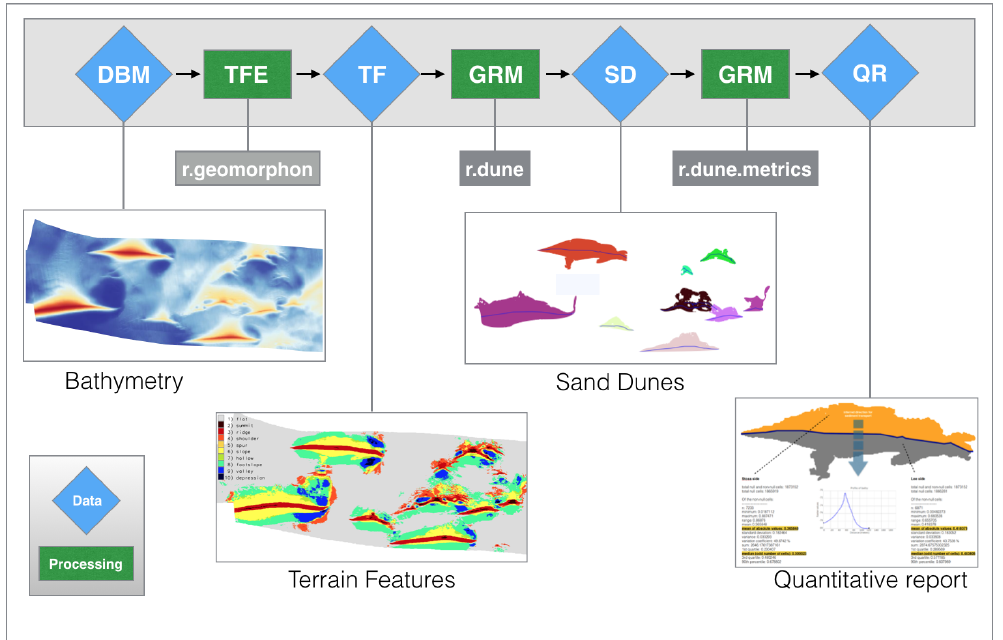
Figure 6. Diagram describing the TFE + GRM approach for the quantitative characterization of sand dunes. The bathymetry used as input is first processed by r.geomorphon for the terrain feature extraction (TFE) and then the output is processed by the two GRASS GIS modules developed in this study: r.dune to identify sand dunes and and r.dune.metrics to produce its quantitative